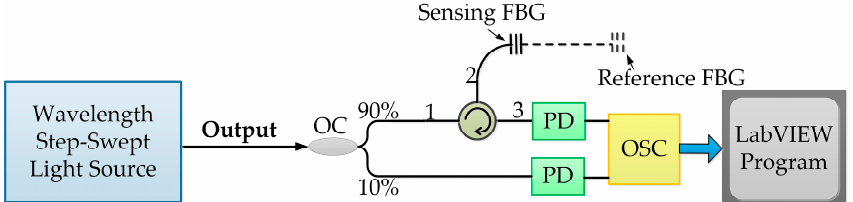
Figure 4. FBG interrogation system for the static strain sensing and the temperature sensing based on the WSSL. FBG: Fiber Bragg grating; PD: Photodetector; OSC: Oscilloscope.